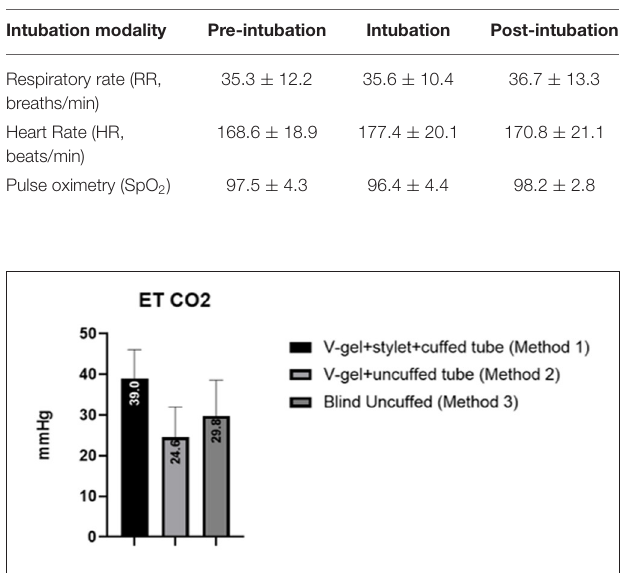
FIGURE 5 | Graph displaying the ETCO 2 values measured for the different intubation techniques. Values are reported as mean (within columns) and standard deviation.